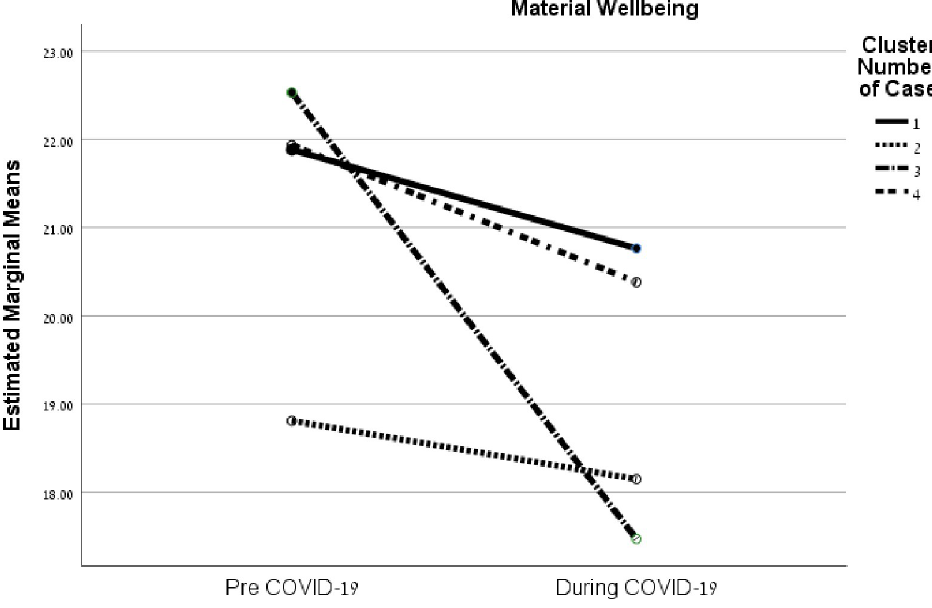
Fig 5. Interactions between coping strategies of families and before/during the COVID-19 crisis on family quality of life factors.